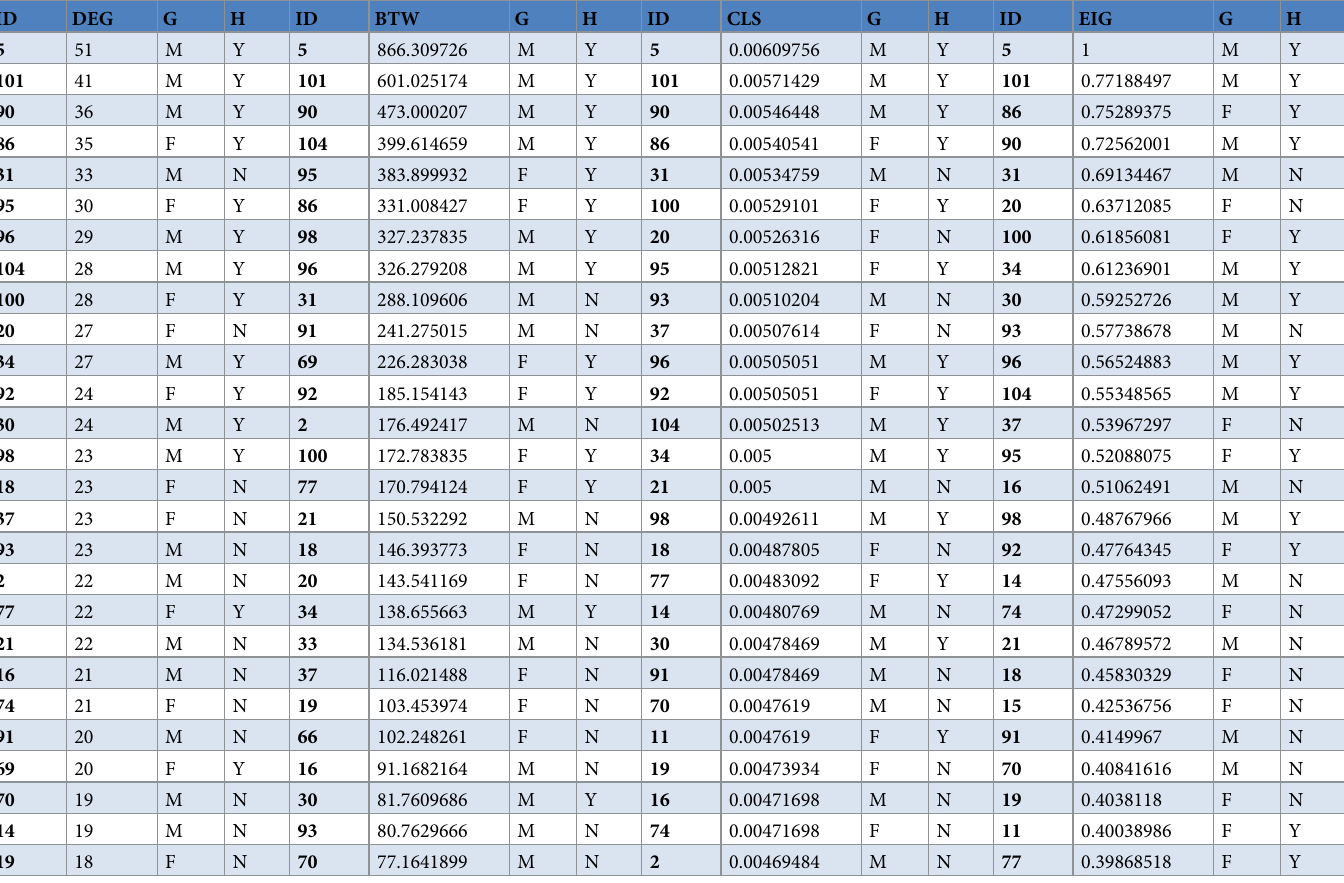
Table 3. CING co-authorship network centralities. The top quantile scored authors (N = 27) sorted based on the centralities degree (DEG), betweenness (BTW), close- ness (CLS) and eigenvector (EIG). The authors’ gender (G) is included (F/M) as well as the annotation whether they are part of the Head (H) group with yes (Y) or no